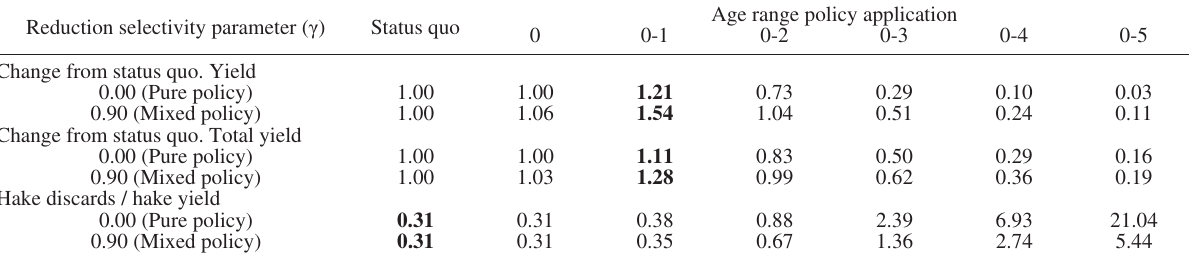
Table 4. – Pure vs mixed sales ban policies. Pure policy corresponds to scenarios in which fish under the age range are banned for sale. Mixed policy corresponds to scenarios in which the ban on sale is applied simultaneously with an improvement in selectivity that represents a 90% reduction in fishing mortality. Yield results refer to valid captures, in weight, for sale without considering discards. The status quo situation represents the situation in which all captures can be sold and there are no selectivity improvements. Values in bold represent the best scenario for each